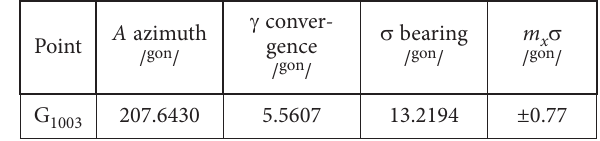
Table 12 lists the resulting orientation measurement values the point G . 1003 Table 12. Resulting orientation measurement